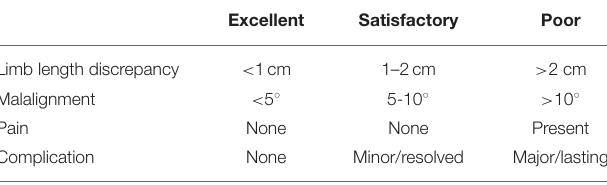
TABLE 2 | Flynn’s titanium elastic nails grading system (functional